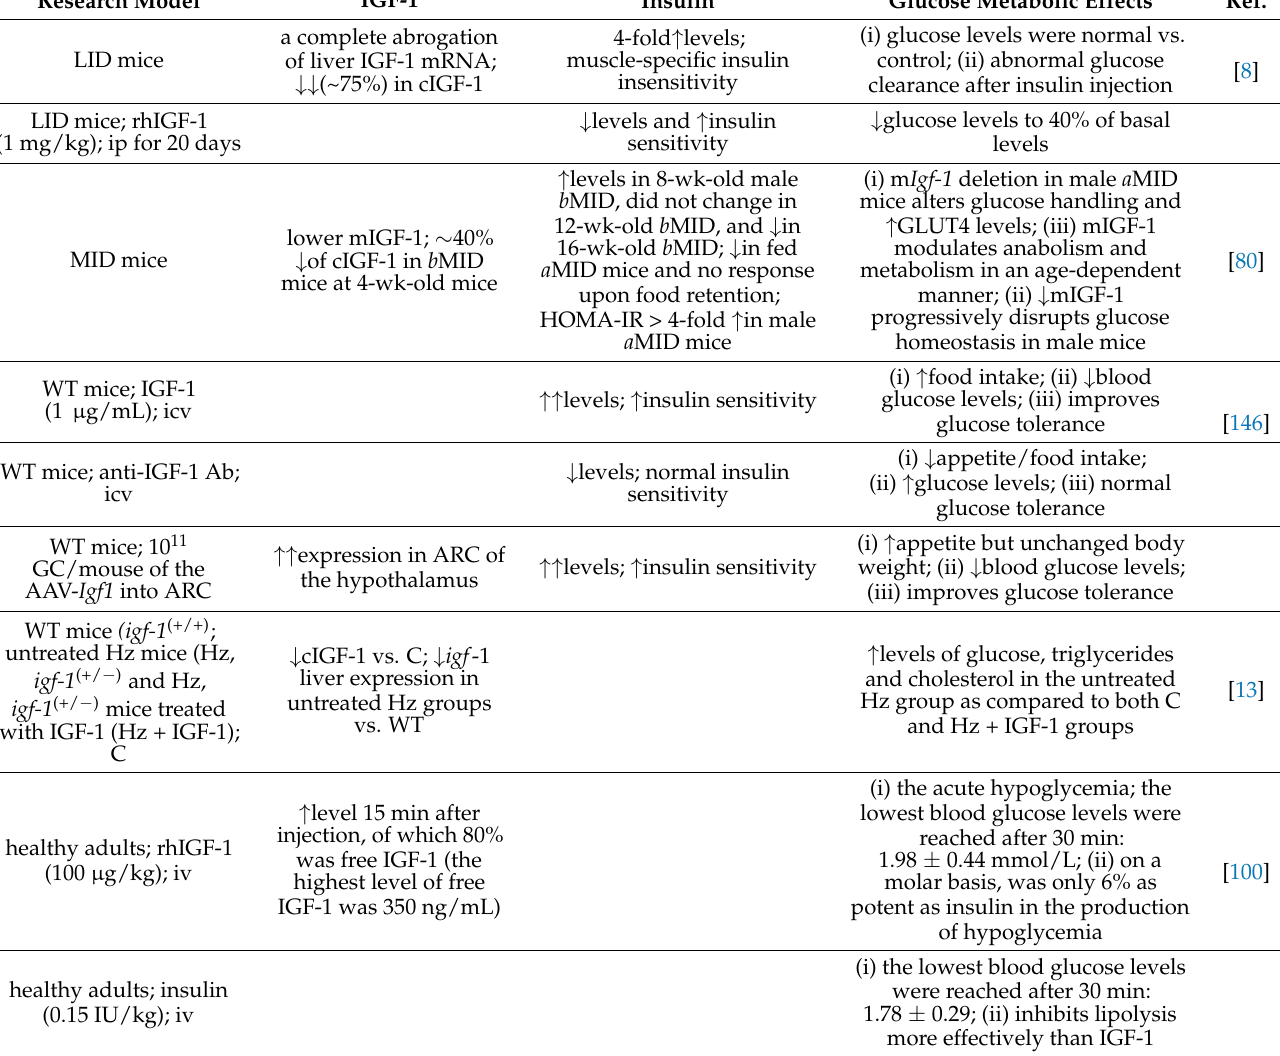
Table 2. The insulin/IGF-1 signaling and glucose metabolic effects in different research models. Research Model